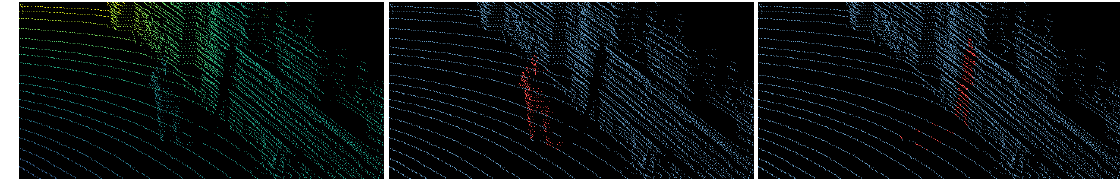
Figure 1. One result of our proposed method. (left) original point cloud, (center) segmentation, (right)